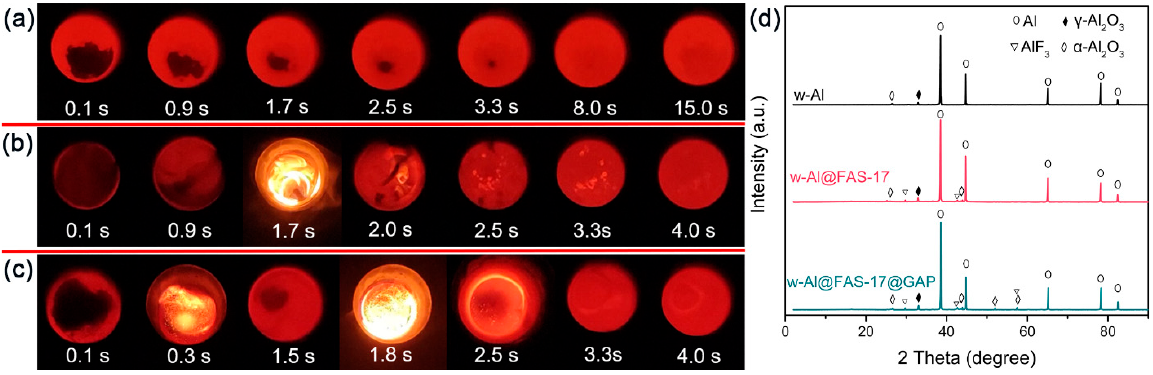
Figure 9. Snapshots of ignition test of w-Al ( a ), w-Al@FAS-17 ( b ) and w-Al@FAS-17@GAP ( c ); XRD patterns ( d ) of the ignition products of w-Al, w-Al@FAS-17 and w-Al@FAS-17@GAP.